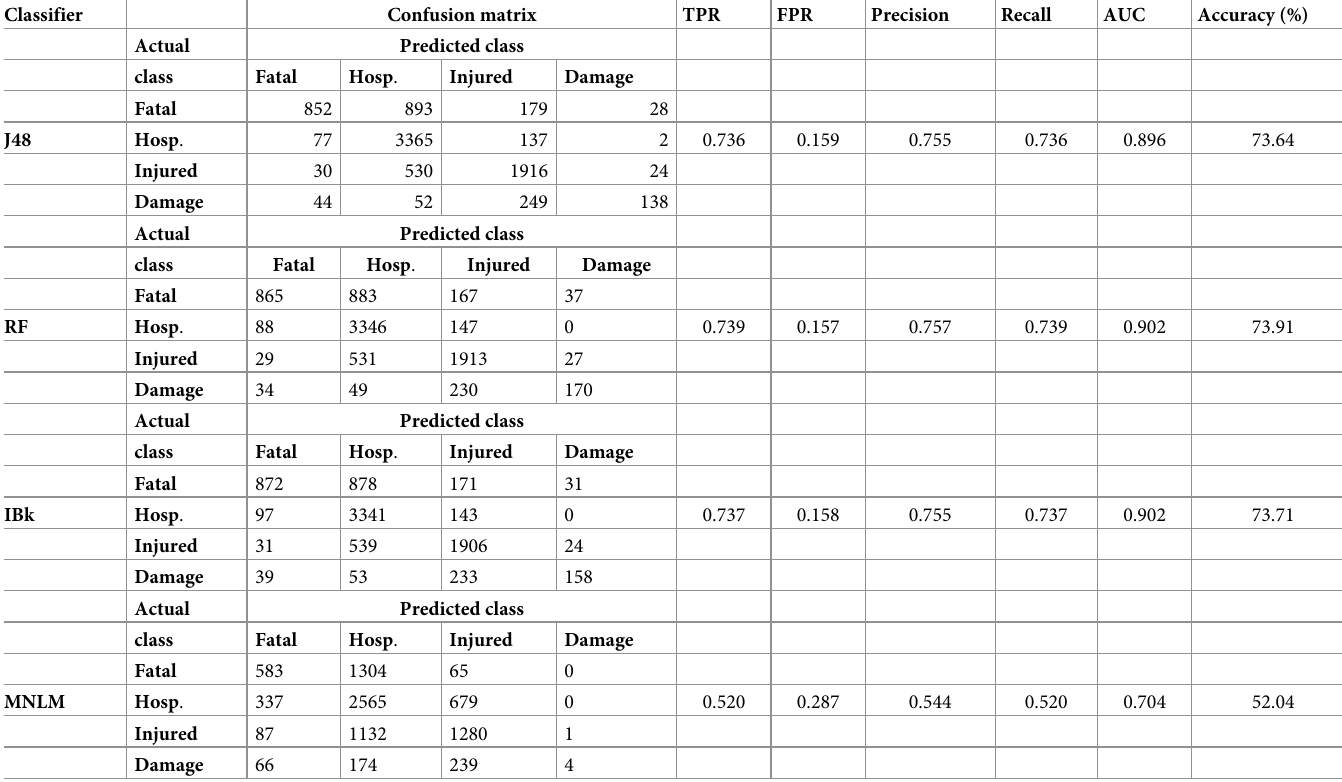
Table 3. Comparison of classifiers performance metrics.